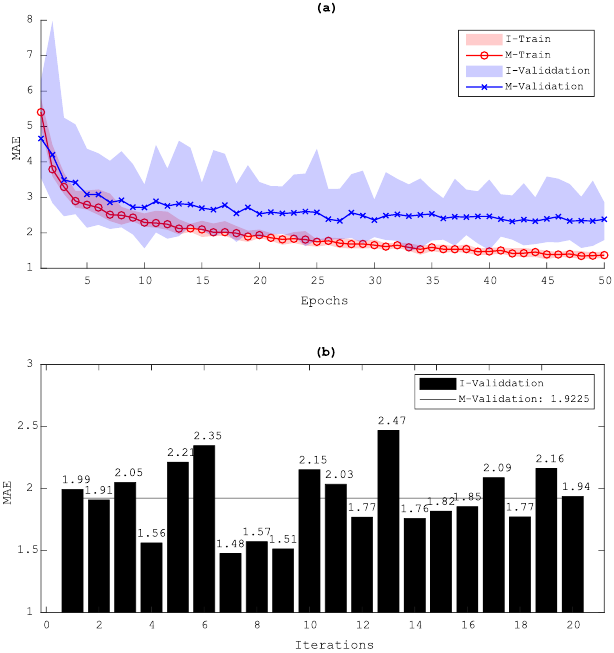
Figure 13. Evolution of the validation loss (MAE) during training for the D1 data set without using data augmentation: ( a ) validation loss and ( b ) minimum MAE of each model and the averaged result; I, iteration model; M, Mean results of the I model.